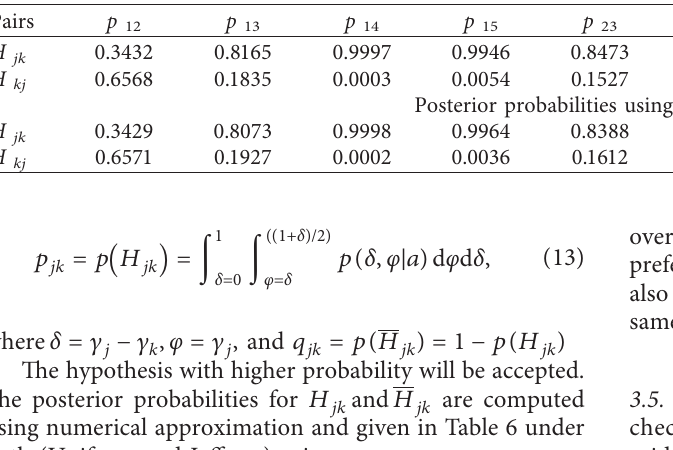
Table 6: Posterior probabilities using uniform